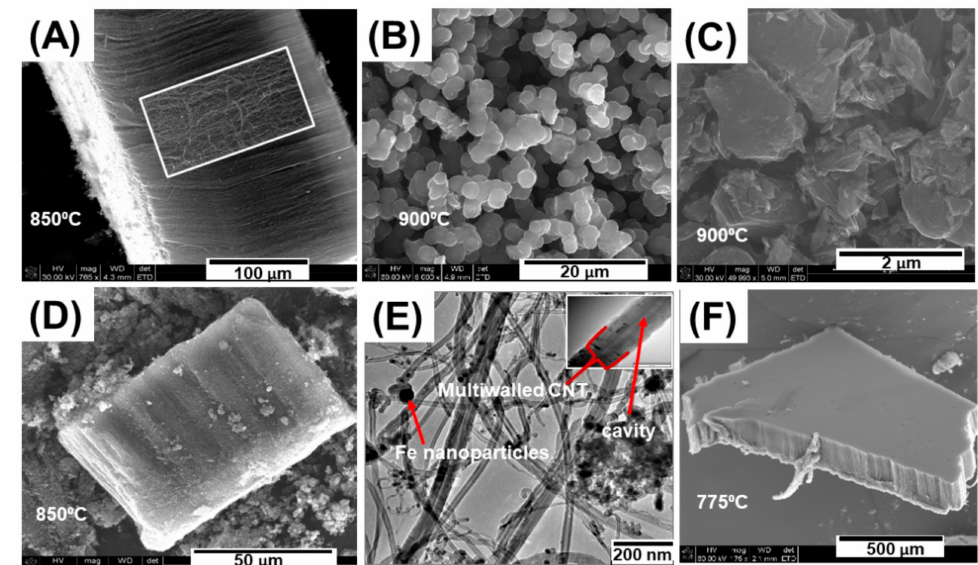
Figure 1. Vertically aligned multiwalled carbon nanotubes (MWCNTs) collected from silicon wafer 14 cm from the furnace inlet at 850 ◦ C ( A ); Carbon nanospheres produced at 900 ◦ C ( B ); Carbon flakes from the furnace centre at 900 ◦ C ( C ); MWCNTs from quartz tube walls at 850 ◦ C ( D ); TEM micrograph of aligned MWCNTs ( E ) with magnified MWCNT insert. MWCNTs grown at 775 ◦ C ( F